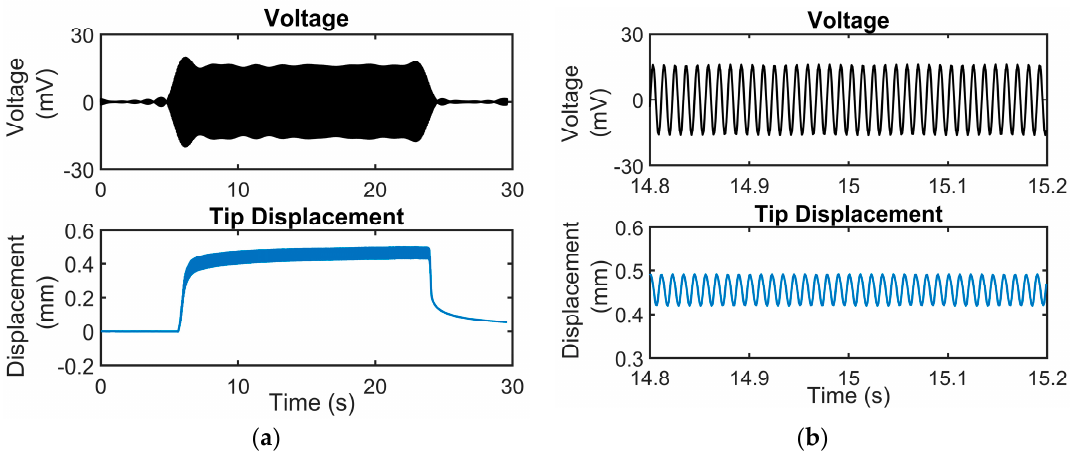
( f ) Figure 6. ( a )–( f ) Sensor voltage output to mini shaker amplitude perturbations at frequencies of 2 Hz, 5 Hz, 10 Hz, 40 Hz, 90 Hz and 180 Hz respectively. The voltage output of the sensor corresponding to its tip displacement at a frequency of 90 Hz is shown in Figure 7. The mini shaker is turned on after 5 s from the start of data acquisition and is continued to vibrate till 25 s after which it is turned off. The tip displacement is zero for the first 5 s as well as from 25 s to 30 s and hence there is no voltage output from the sensor corresponding to no change in strain. There is a corresponding voltage output from the sensor for the time the mini shaker is on. A zoomed in view of the plot shows that the tip displacement and the voltage output are both sinusoidal curves. This also seems to suggest that a repeatable voltage output can be obtained from the sensor for tip displacements. The comparison between the frequency measured by the PVDF sensor and that measured by the